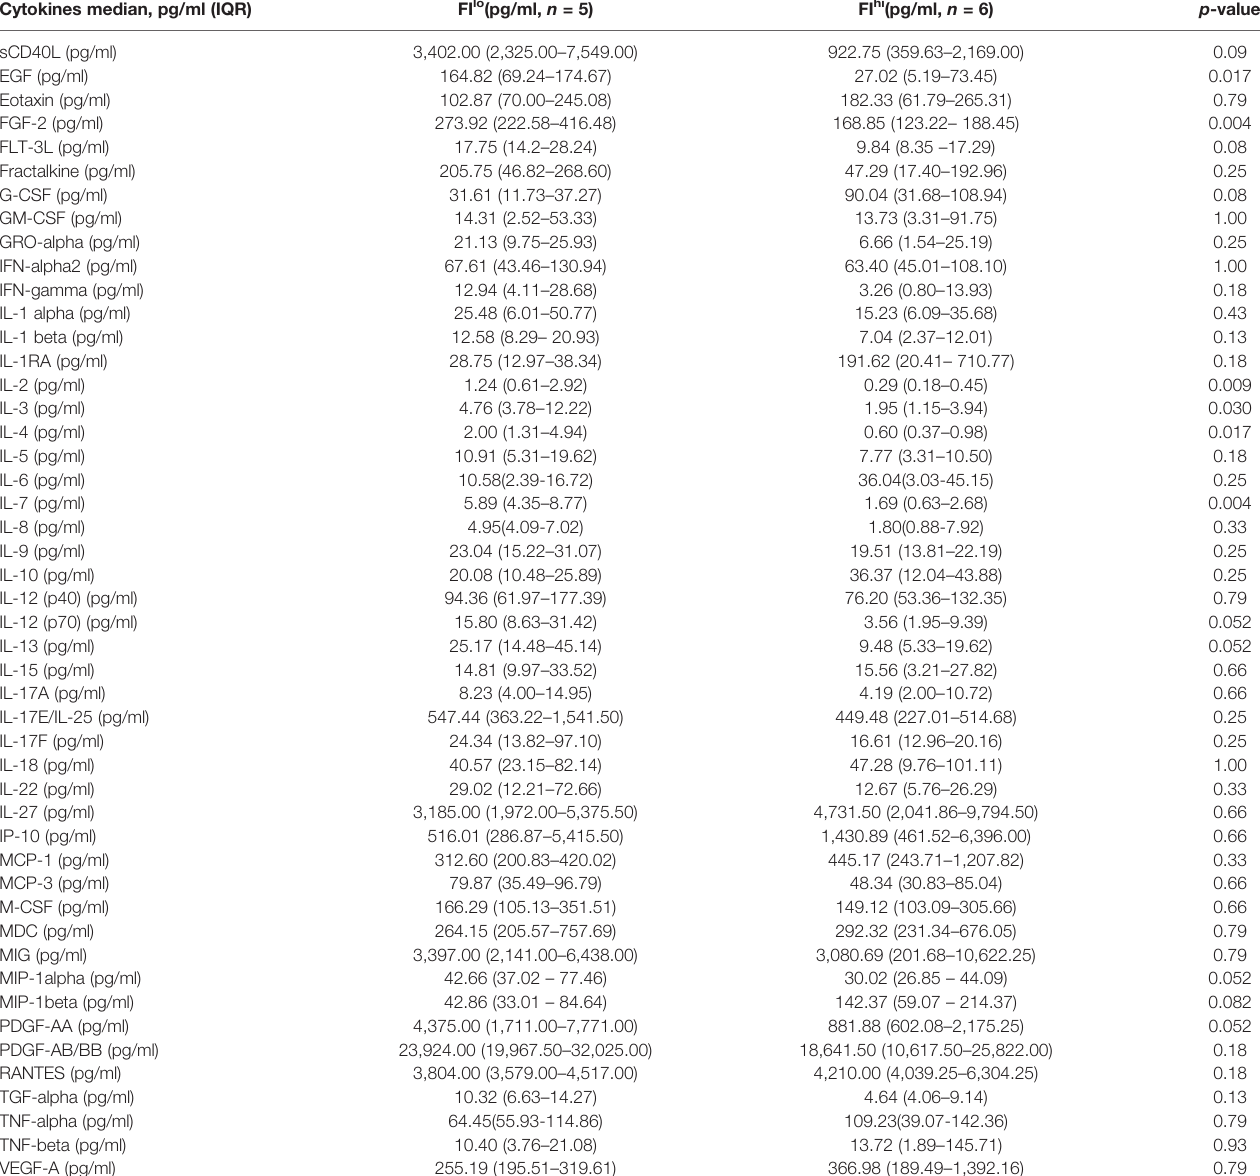
TABLE 2 | Serum soluble factors and cytokines in patients with severe COVID-19 when categorized by pulmonary fi brosis index. Cytokines median, pg/ml (IQR) FI lo (pg/ml, n =